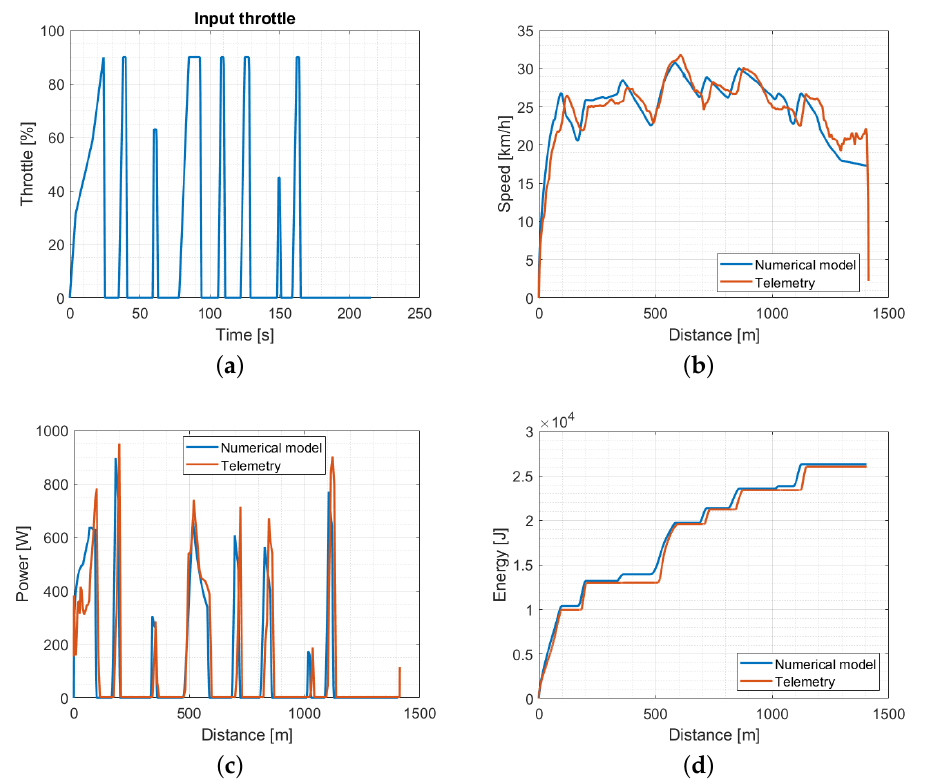
Figure 7. Model validation. ( a ) Input throttle. ( b ) Vehicle speed. ( c ) Electric power. ( d ) Energy